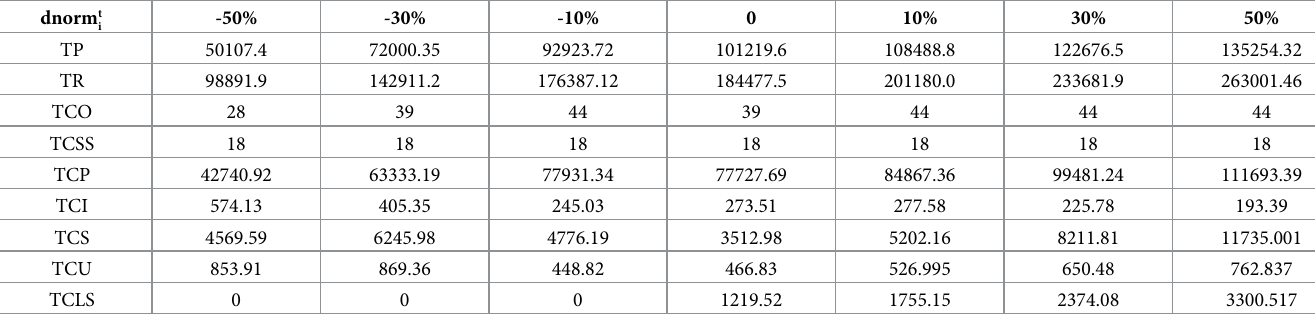
Table 5. The costs and sales profits for the changes in demand.